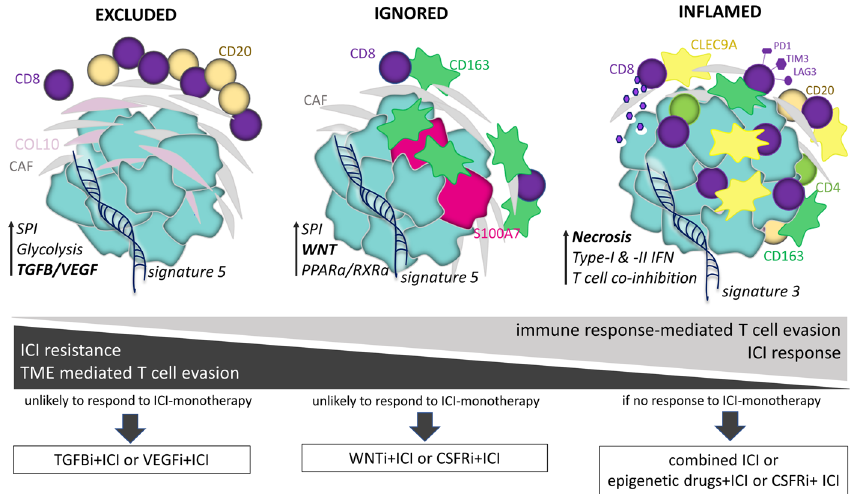
Fig. 6 Illustration of immune contextures per spatial phenotype in relation to paths of T cell evasion as well as response to ICI. Distinctive and dominant pathways (in bold), when targeted in an immunophenotype-speci fi c manner (in boxes), would sensitize TNBC to ICI (see Discussion section for